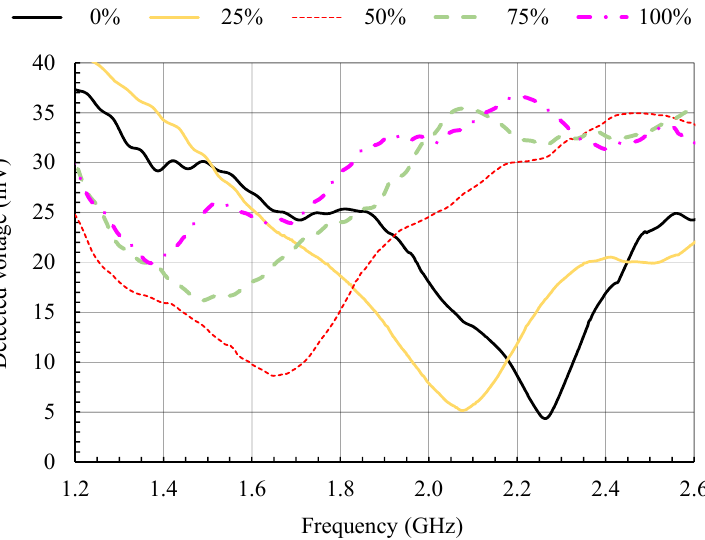
Figure 20. Average measured detected voltages in reflection measurement mode setup for ten measurement series and for moisture content of 0%, 25%, 50%, 75%, and 100%.